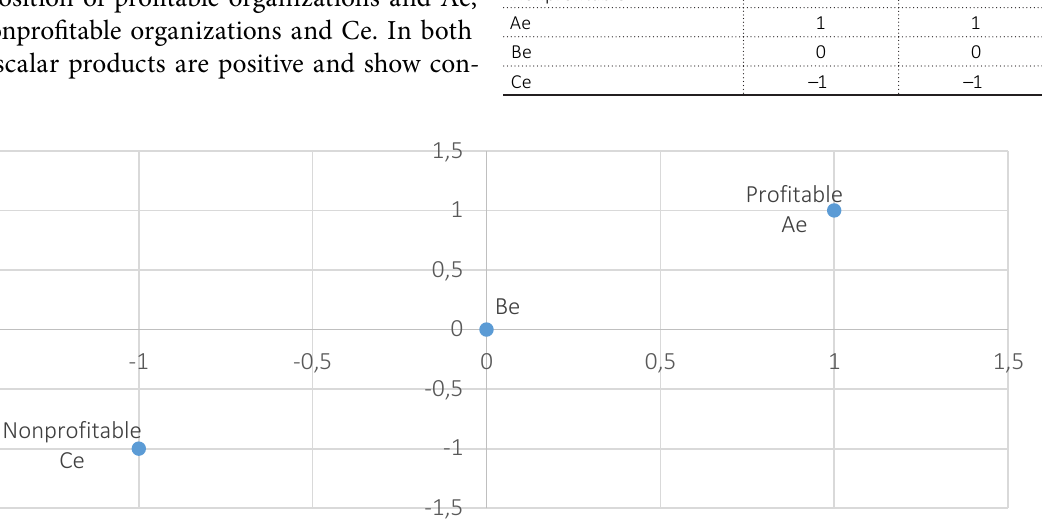
Figure 2. Representation of the environmental factorial correspondence